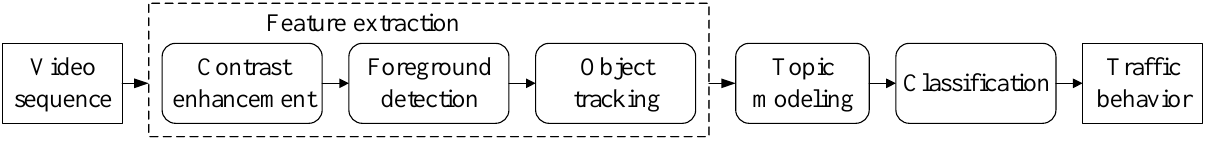
Figure 1. Proposed traffic behavior recognition